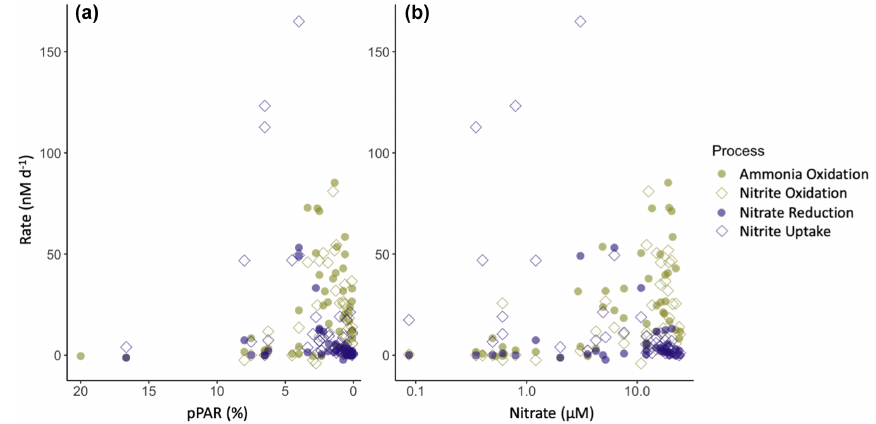
Figure 7. Relationship between nitrite cycling rates and percent surface PAR (a) and nitrate concentration (b) . Phytoplankton-dominated processes are shown in purple, and nitrifier processes are shown in green. Nitrite production processes are shown as filled circles, and nitrite consumption processes are open